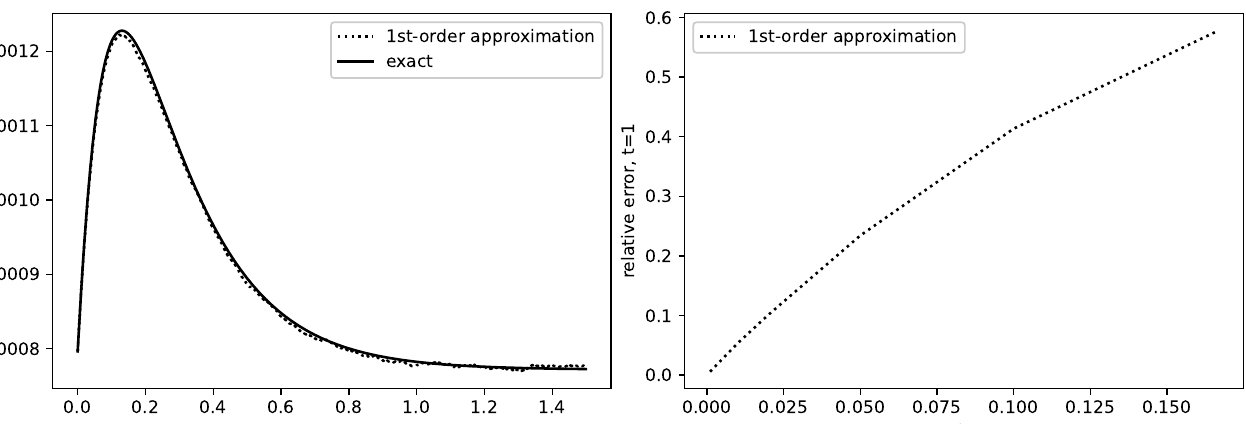
Figure 1. Comparison of E f ( ˆ X x σ 2 = 0.6, a = 0.8, b = 5, the number of iterations N = 1,000,000. Left : h = 0.001; Right : the relative error at t =